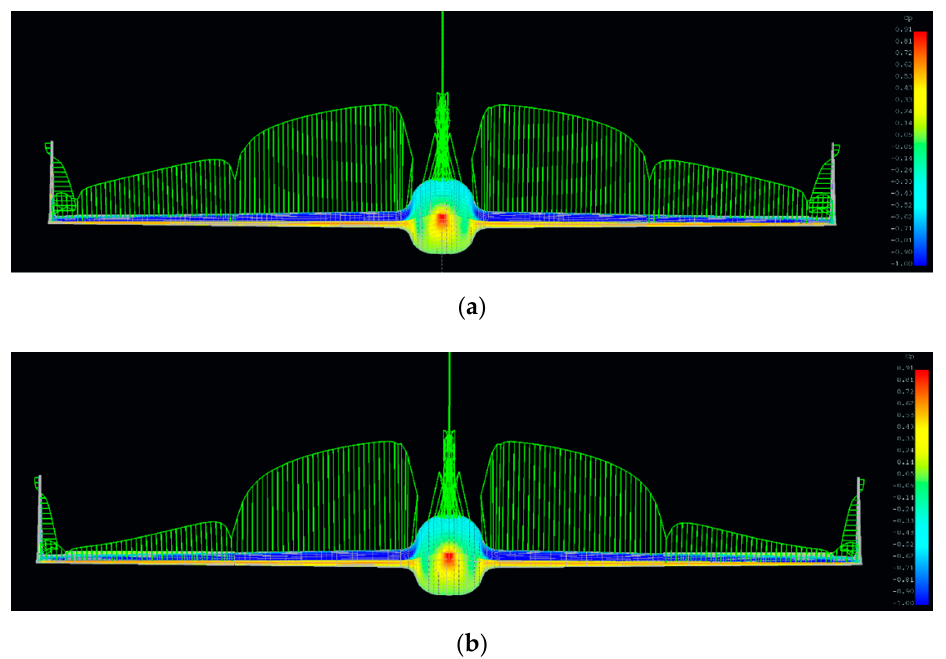
Figure 5. Aileron deflection influence on the aerodynamic loading distribution of the wing for ( a ) –5°, and ( b ) –10°.